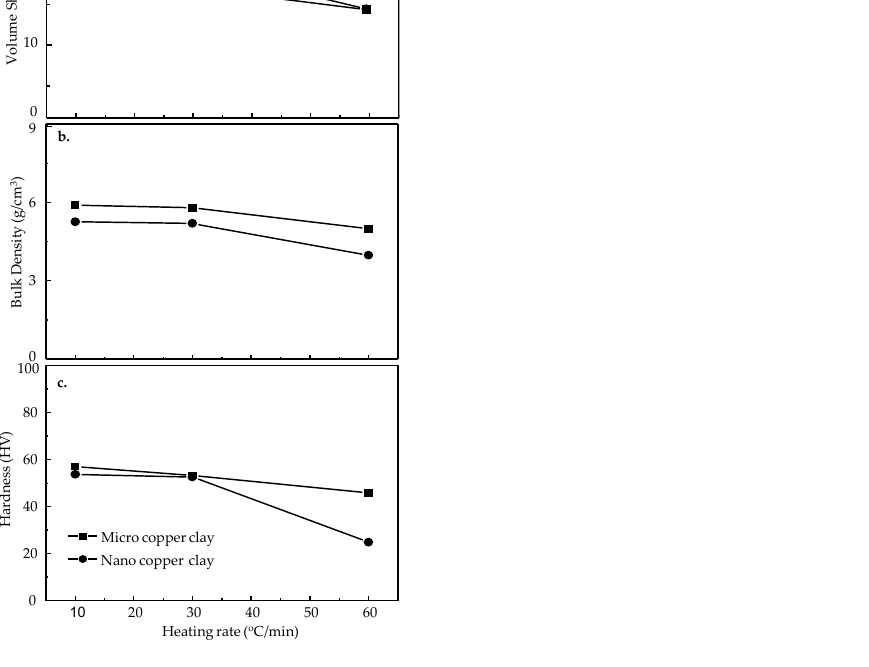
Figure 8. ( a ) Volume shrinkage, ( b ) bulk density, and ( c ) hardness of sintered nano- and micro-copper clays with different heating rates.